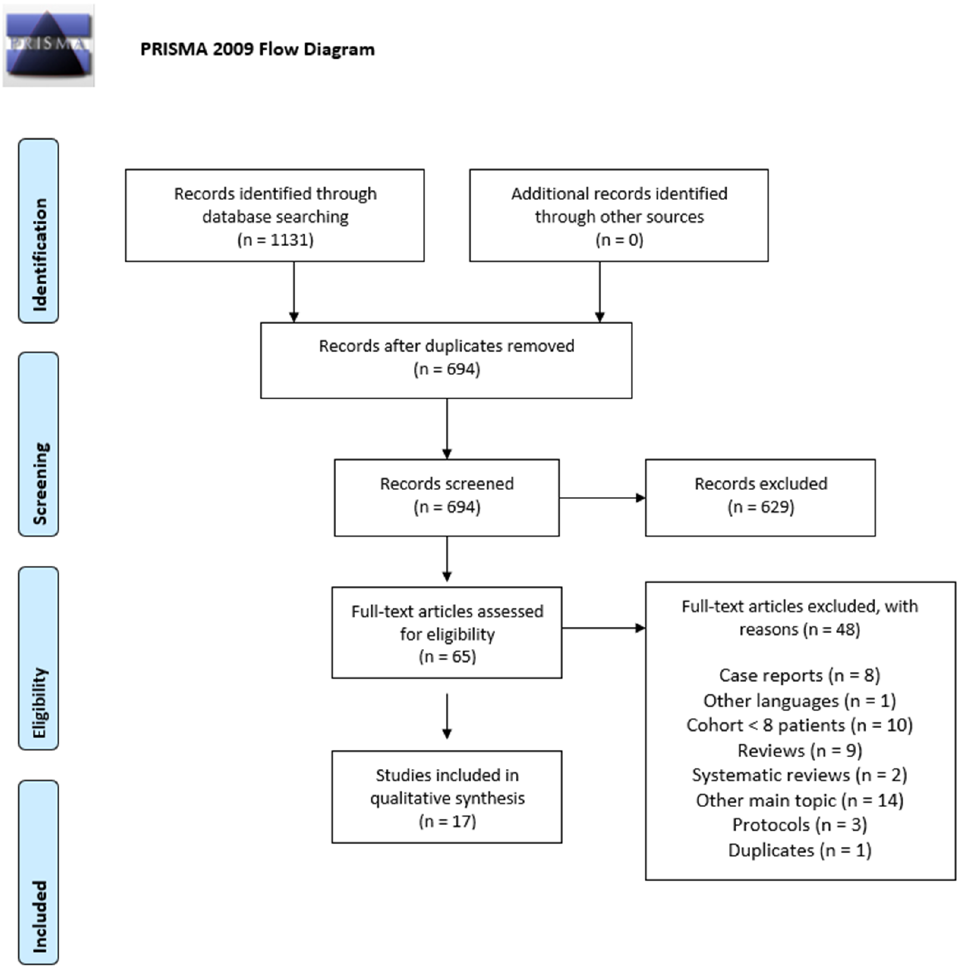
Figure 3. Flow diagram of the study according to Preferred Reporting Items for Systematic Reviews and Meta-Analyses (PRIMA) guidelines [12]. Table 1 summarizes the features, key outcomes, degree, and grade of existing evi- dence concerning the impact of iOCT in FTMH surgical management. Table 1. Characteristics, quality, and level of evidence of the included studies and features of the iOCT cited by these articles.